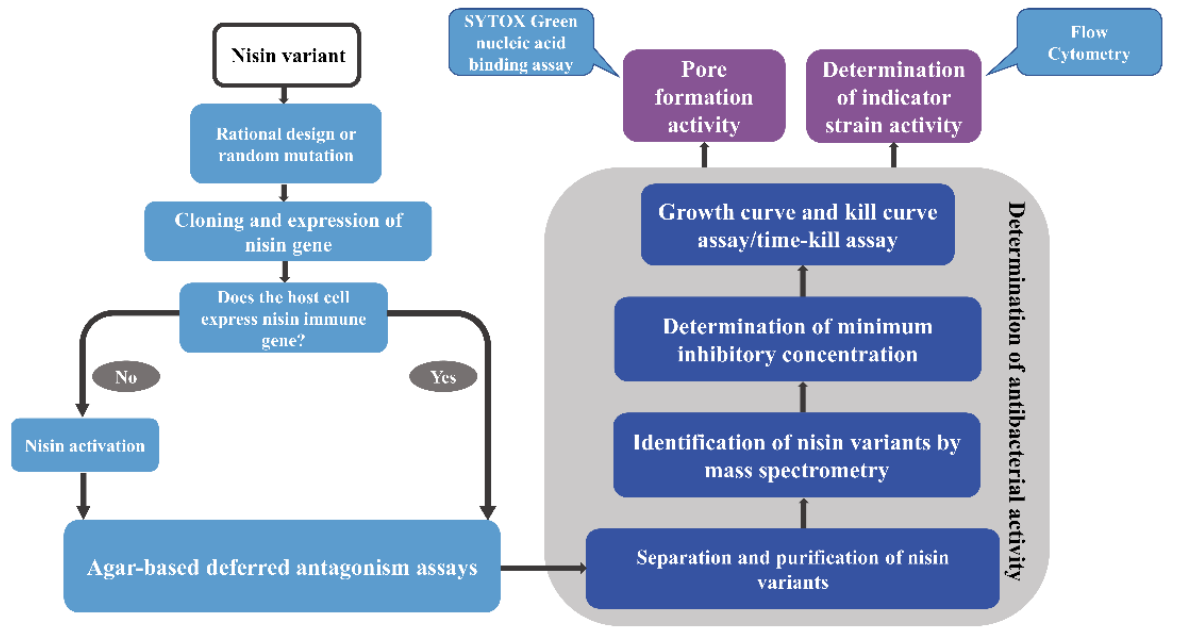
Figure 3. Overview of the approach employed in biosynthesis of nisin variants in different hosts and characterization of nisin variants.